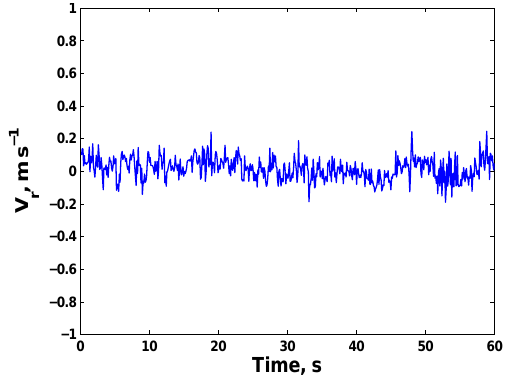
Figure 10. One minute of corrected V r data within ground echo measured during the test flight of 3 October